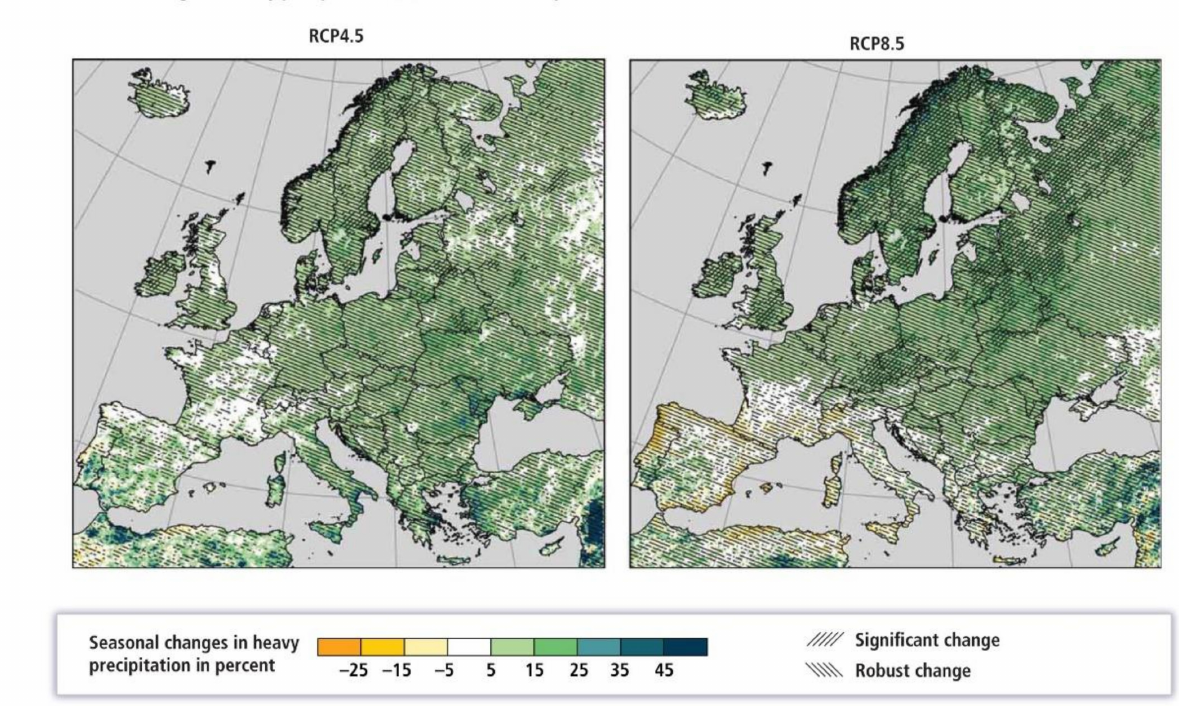
Figure 1. Projected seasonal changes in heavy precipitation in the months from December to February (DJF) ( a ) and June to August (JJA) ( b ) for RCP 4.5 and RCP 8.5. (Modified from [9]). Traditionally, most European countries had based their flood management (FM) strate- gies on prevention and defense against floods [1]. However, the increase in extreme